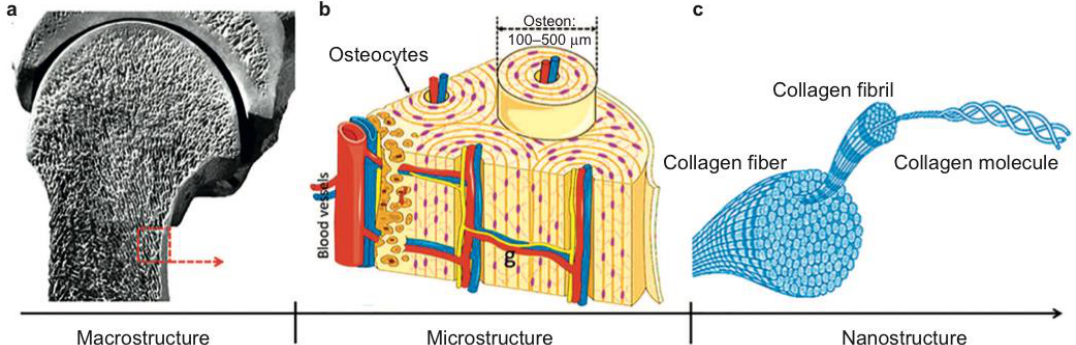
Figure 1. Hierarchical organization of bone tissue: ( a ) Macrostructure of cortical (dense shell) and cancellous bone (porous bone at both ends); ( b ) Microstructures of the osteons (20–30 concentric layers of collagen fibres, called lamellae) and trabeculae; ( c ) Nanostructures of collagen fibrils, which form the collagen fibres. The HA crystals are embedded in these gaps between collagen molecules and increase the rigidity of the bone